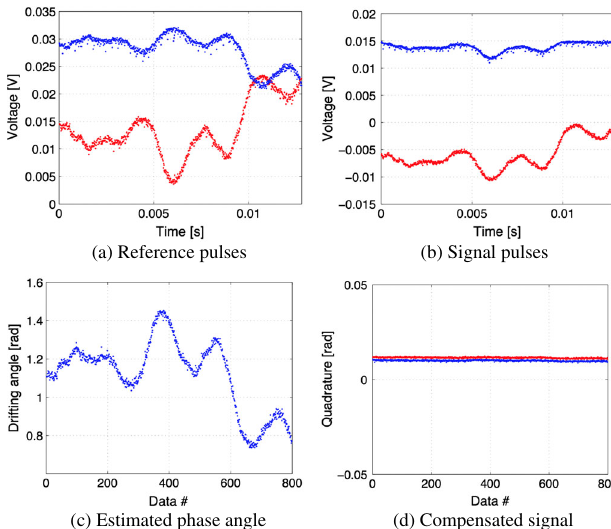
FIG. 5. Phase-drift estimation and compensation for constant signal pulses. Bob ’ s measured voltages proportional to mean values of Q quadrature (blue dots) and P quadrature (red dots) for ˆ θ (a) reference pulses and (b) signal pulses. (c) Estimated values of the phase difference between Alice ’ s and Bob ’ s frames. Each data point is calculated as in Eq. (4) using mean quadrature values q p B R obtained from sequential homodyne measurements B R and on a pair of twin reference pulses. (d) Mean values of Q quadrature (blue dots) and P quadrature (red dots) for signal ˆ θ pulses, after a rotation by the angle − to compensate for the phase drift. Fig. 5(c), and mean quadrature values of signal pulses, compensated in accordance with the estimated phase, are shown in Fig. 5(d). The compensation successfully recov- ers the constant signal that Alice sent despite the variation of the phase difference between Alice ’ s and Bob ’ s frames. signal is shown in Fig. 6. The variance of the reconstructed signal data is 1.16.